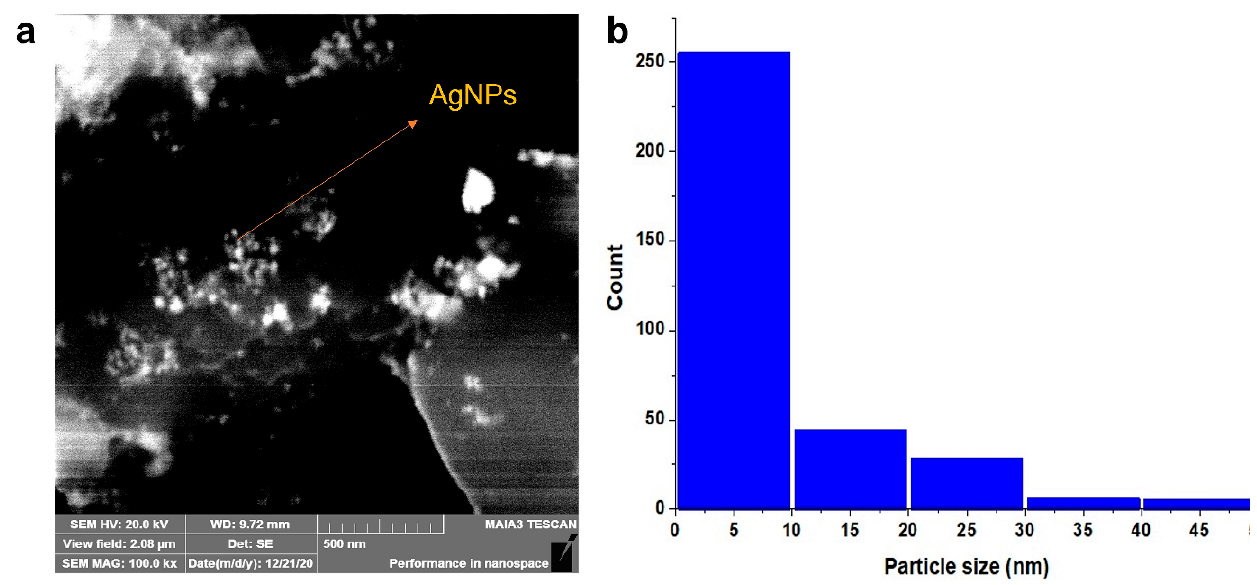
Molecules 2022 , 27 , x FOR PEER REVIEW Figure 4. SEM analysis of AgNPs, ( a ) SEM, ( b ) particle size distribution. Figure 4. SEM analysis of AgNPs, ( a ) SEM, ( b ) particle size distribution.